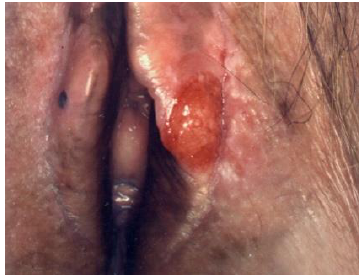
Figure 7. Invasive